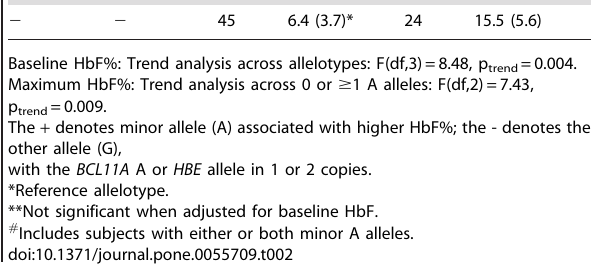
Figure S1 Histograms for Baseline, Maximum and Delta HbF%. Figure S2 Power analyses based on minor allele fre- quencies. S2A. Baseline HbF. S2B. Maximum HbF